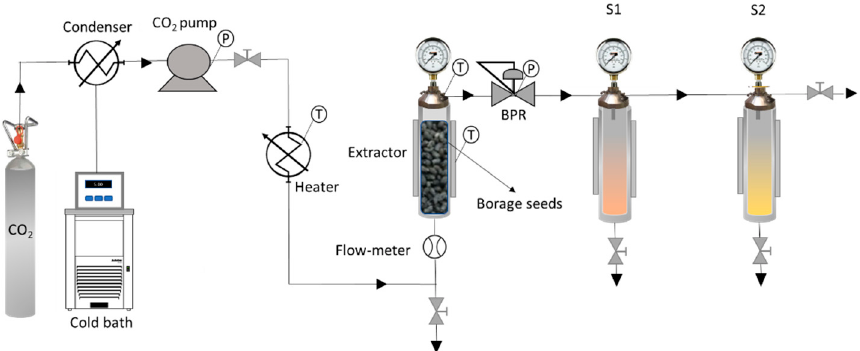
Figure 1. Simplified diagram of the supercritical extraction and fractionation equipment (BPR: automated back pressure regulator, S1 and S2: cyclonic separators, T: temperature, P: pressure).